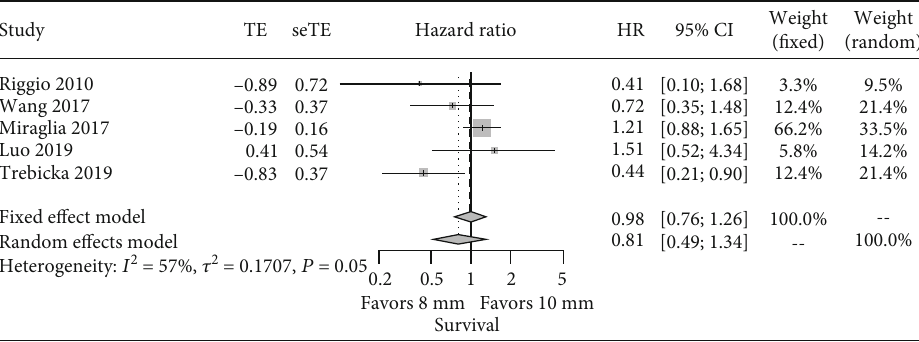
Figure 4: Meta-analysis of HR of survival: 8 mm vs. 10